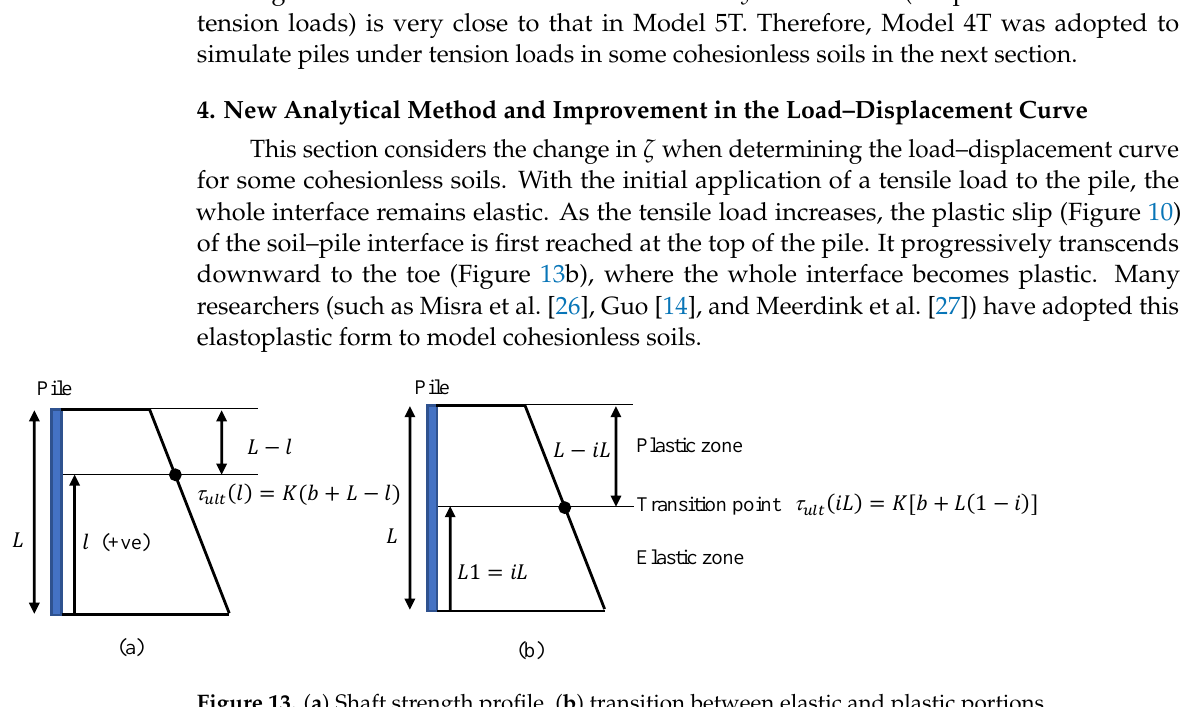
Figure 13. ( a ) Shaft strength profile, ( b ) transition between elastic and plastic portions.